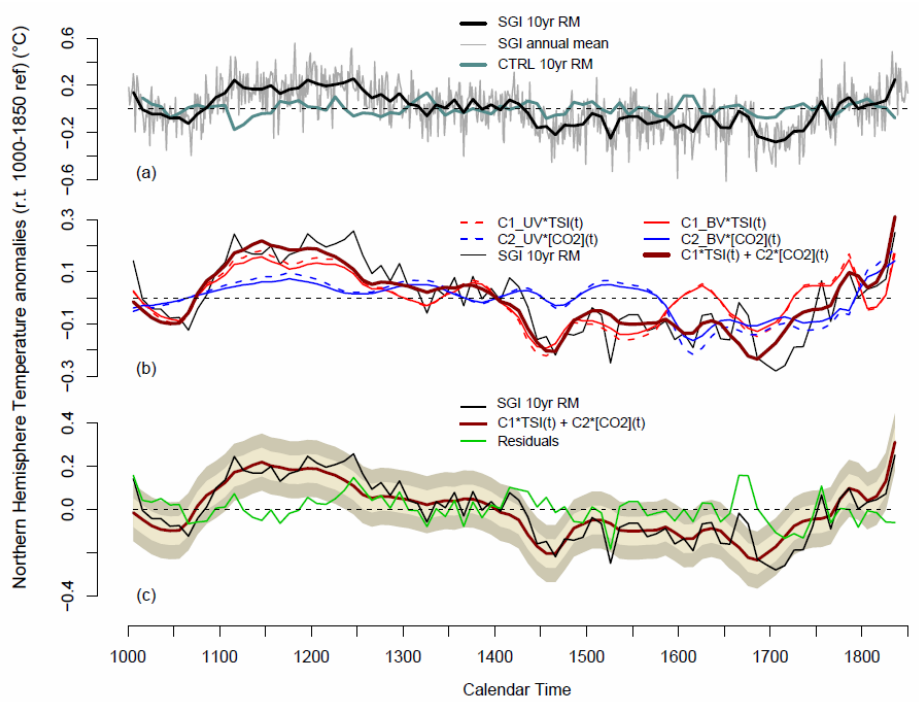
Figure 3: (a) surface temperature anomalies relative to 1000-1850 AD reference period averaged over the Northern Hemisphere in SGI, on annual mean (grey line). The thick black line is the ten-year running mean applied on the annual averages, sampled every ten years to keep the number of degrees of freedom. The same treatment is done on the CTRL simulation, drawn on grey blue. (b) Fingerprints of solar (red lines) and CO 2 (blue lines) forcings, estimated with univariate (dashed lines) and bivariate linear regressions and anomalies of TSI and CO 2 concentrations relative to the 1000-1850 AD period. The fingerprint of both solar and CO 2 forcings together is represented by the dark red line. The black thin line shows the 10yr-running mean of the NH temperature of SGI presented on panel (a). (c) Fingerprint of both solar and CO 2 forcings together (dark red line). The residuals corresponding to SGI minus total forced fingerprint are represented by the green line. The light shaded area shows the interval corresponding to ± 1 standard deviation (SD) of the residuals, and the dark shaded area depicts the ± 2SD of the residuals. The black line plotted over is the ten-year NH temperature of SGI presented on panel (a).